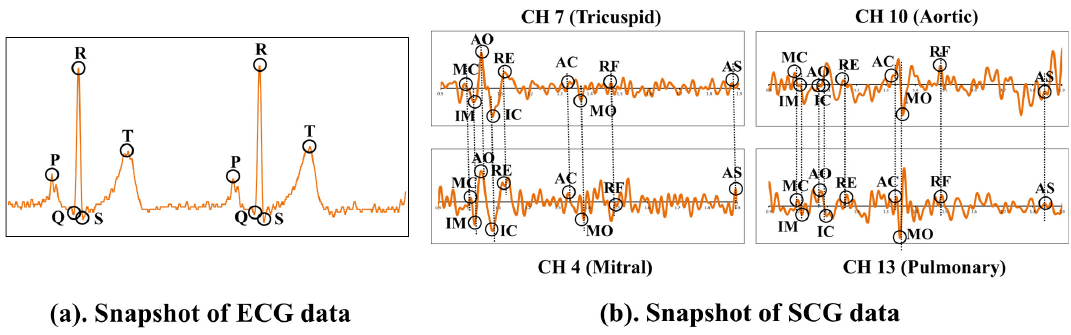
Figure 14. Visualization of ECG and SCG data acquired from